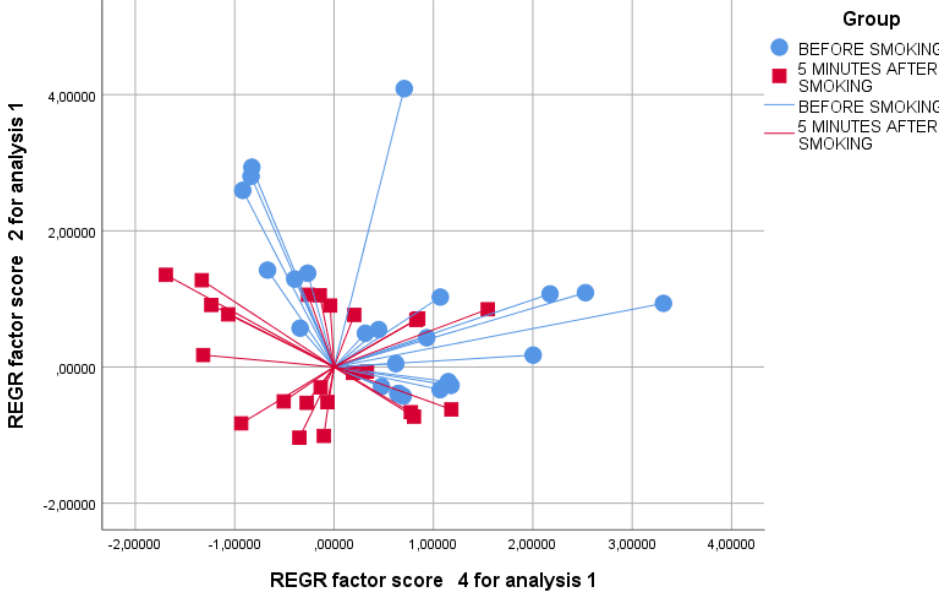
Figure 2. Two-dimensional PCA plot showing the discrimination of breathprints before smoking (blue circles) and 5 min after smoking (red squares). REGR = regression.